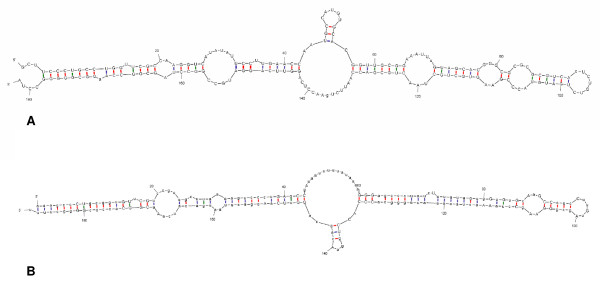
Secondary structure of the putative 6S RNA in IG1_2935724 and the 6S RNA consensus structure. A. Secondary structure obtained for the intergenic region spanning nucleotides 2935805 to 2935985 (B. cenocepacia J2315; chromosome 1) as predicted by mfold using standard settings [76]. B. Secondary structure of the 6S RNA consensus structure (RFAM database [53]).